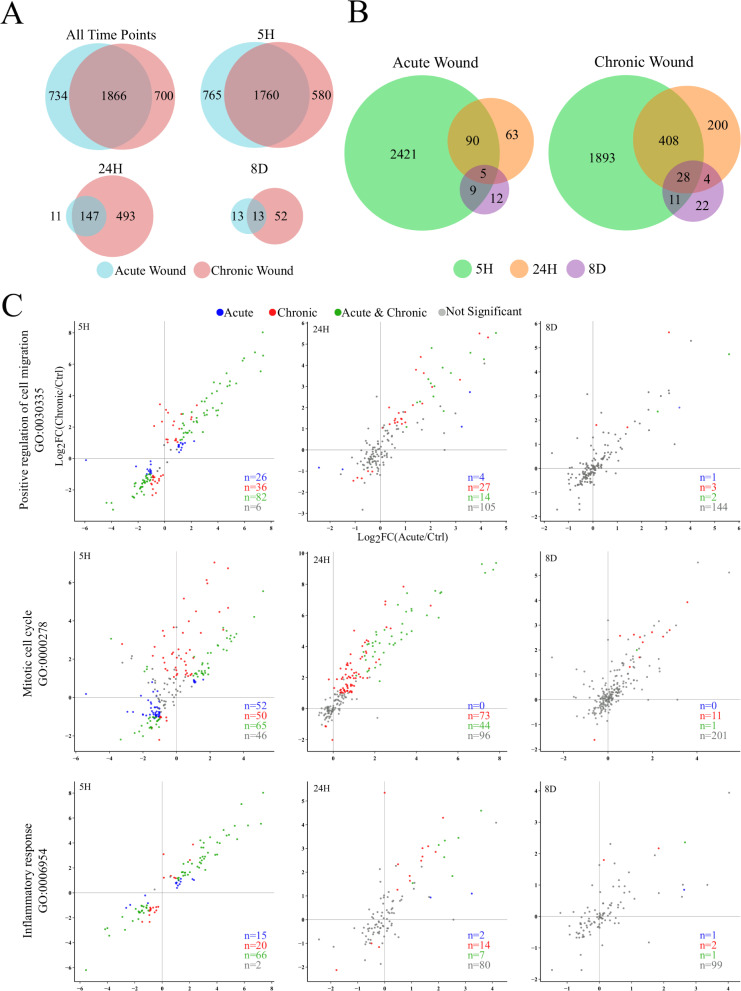
Differential expression and gene ontology analysis.(A) Venn diagrams comparing the differentially expressed genes (DEG; FDR ≤ 0.05 and ≥ 2-fold change) at three time points following acute or chronic wound treatments. (B) Venn diagrams showing the overlap of DEGs in the acute or chronic wounding condition alone after wounding. Chronic wounding results in prolonged misregulation of gene expression compared to acute wounding, as seen by the increase in the number of DEGs at both 24-hours and 8-days post wounding. (C) Scatter plots of DEGs showing log2 transformed fold change (Log2FC) of acute (X-axis) or chronic (Y-axis) compared to unwounded controls at 5 hours (5H), 24 hours (24H) and 8 days (8D) after wounding. DEGs in either acute wounding alone or chronic wounding alone are colored blue and red, respectively. DEGs in both wounding conditions are colored green, and genes that are not significantly changed (either FDR > 0.05 or < 2-fold change) are colored grey. All genes are differentially expressed in one or more time point. Gene ontology groups are significantly enriched based on the total number of differentially expressed genes.